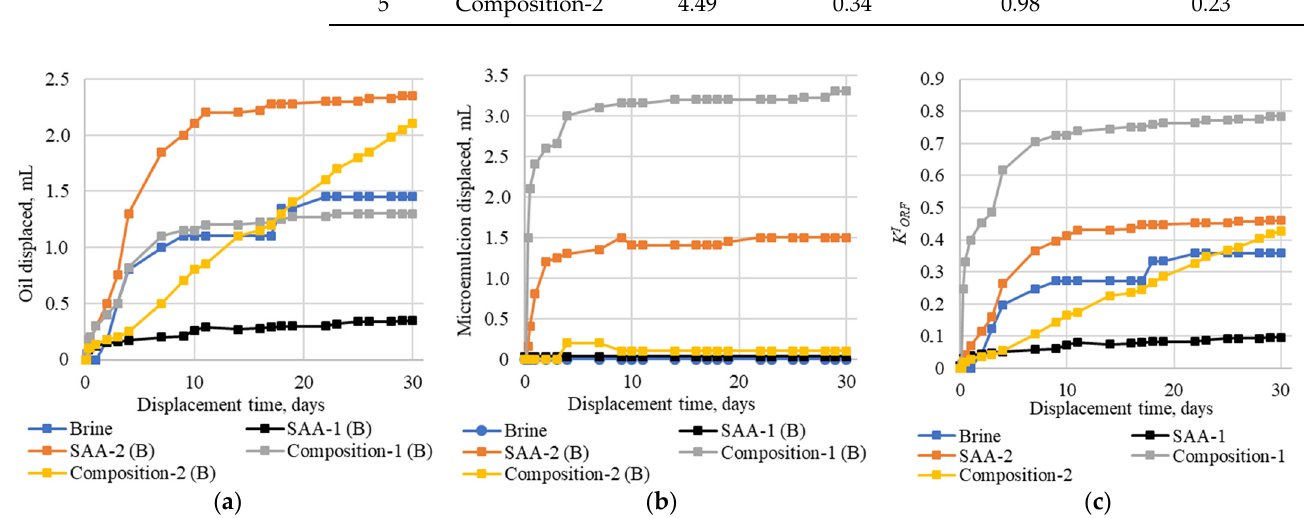
Figure 8. Displacement rate and oil displacement coefficient during spontaneous imbibition for Ver- eian horizon cores of: ( a ) oil; ( b ) microemulsion; ( c ) dynamic of oil displacement coefficient during Amott cell experiment, K IORF unit fraction. The dynamics of oil displacement efficiency ( K IORF ) for the Bashkirian stage and Vereian horizon are shown in Figures 7c and 8c. These graphs show the overall effectiveness of each surfactant and composition for the represented production zones. Thus, it can be observed that, with a similar nature, the effectiveness of surfactants, in particular Composition-1, is higher for the Bashkirian stage than for the Vereian horizon.